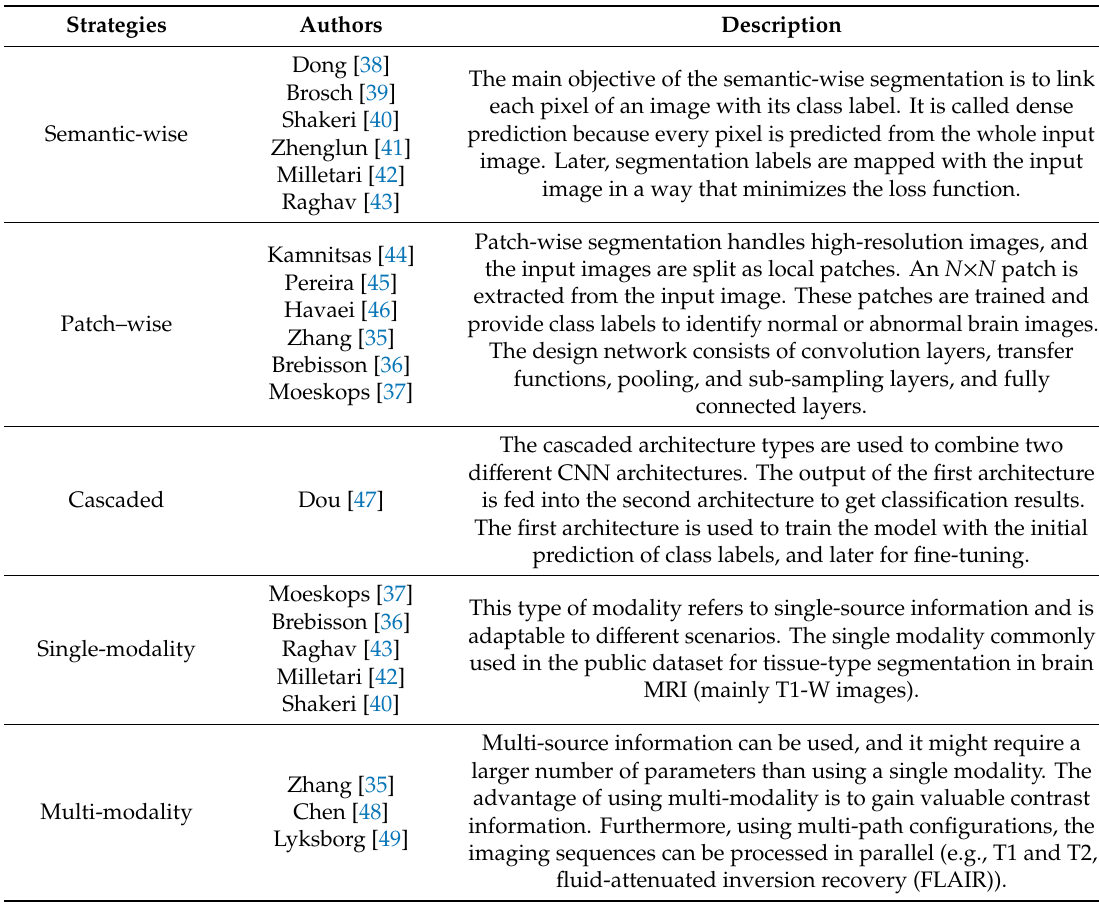
Table 2. Categorization of segmentation methods using CNN architecture on brain